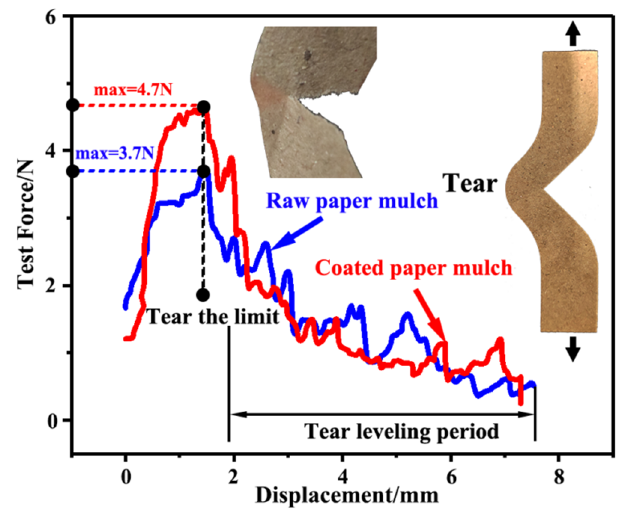
Figure 12. Tear graph